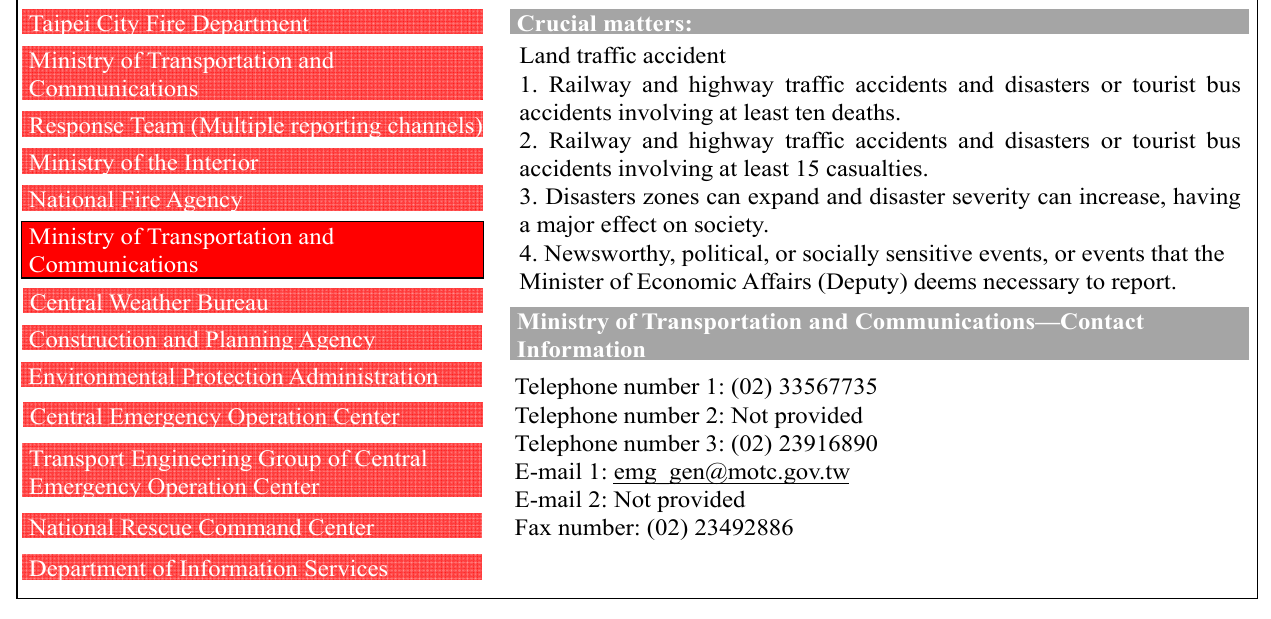
Figure 8. Television screen display of intelligent disaster prevention system in Taipei Main Station. (Source: Research Data).